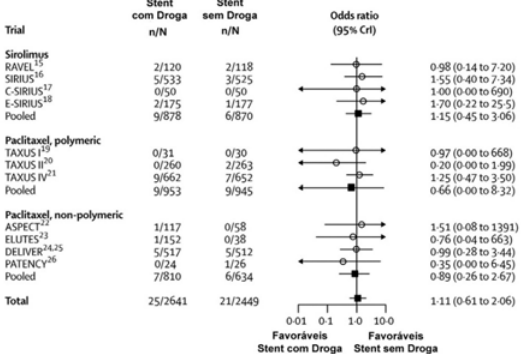
Fig. 4 - Metanálise (Forest plot) de Trials sobre mortalidade comparando “Stent” com droga x “Stent sem droga. Não há diferença - Guyton, 2006 [2]